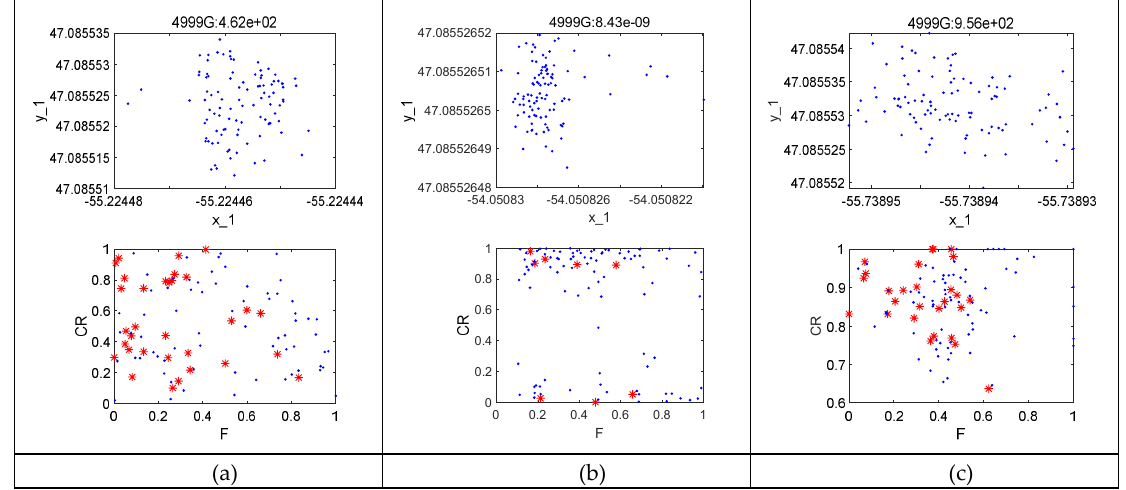
Figure 2. Individual and parameter distribution maps of three parameter strategies for f2: ( a ) random strategy; ( b ) jDE strategy; and ( c ) SHADE